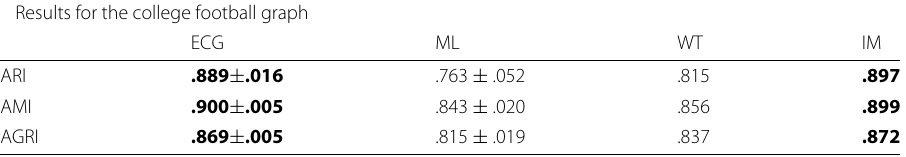
Table 1 We run each clustering algorithm 100 times on the college football dataset, namely: ECG, Louvain (ML), WalkTrap (WT) and InfoMap (IM) Results for the college football graph ECG ML WT IM ARI .889 ± .016 .763 ± .052 .815 .897 AMI .900 ± .005 .843 ± .020 .856 .899 AGRI .869 ± .005 .815 ± .019 .837